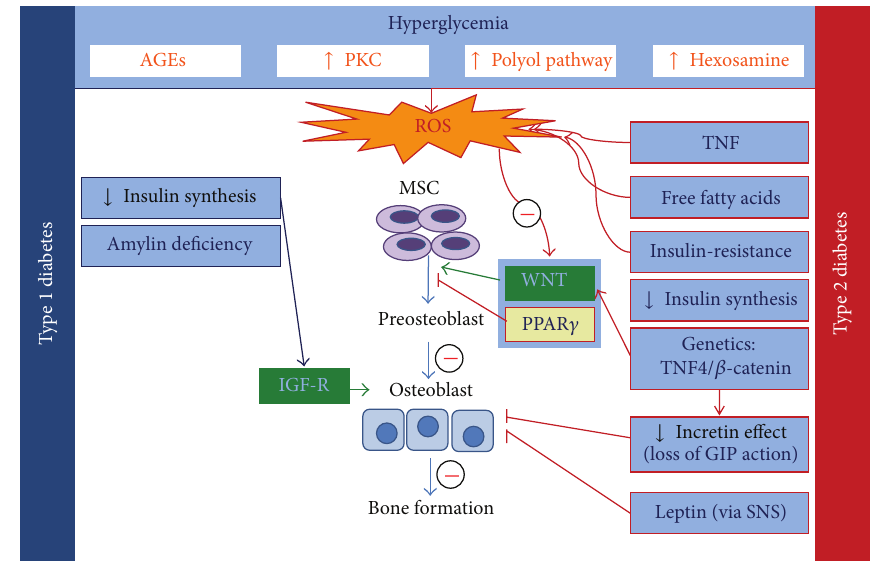
Figure 1: Diabetes-bone interaction. Several factors associated with diabetes may impair bone health. These factors may create, either directly or indirectly, a milieu that disrupts osteoblast differentiation and function, describing a low bone turnover phenotype. AGE: advanced glycation end-products; PKC: protein kinase C; ROS: reactive oxygen species; MSC: mesenchymal stem cells; TNF: tumor necrosis factor; GIP: gastric inhibitor peptide; IGF-R: insulin-like growth factor receptor; SNS: sympathetic nervous